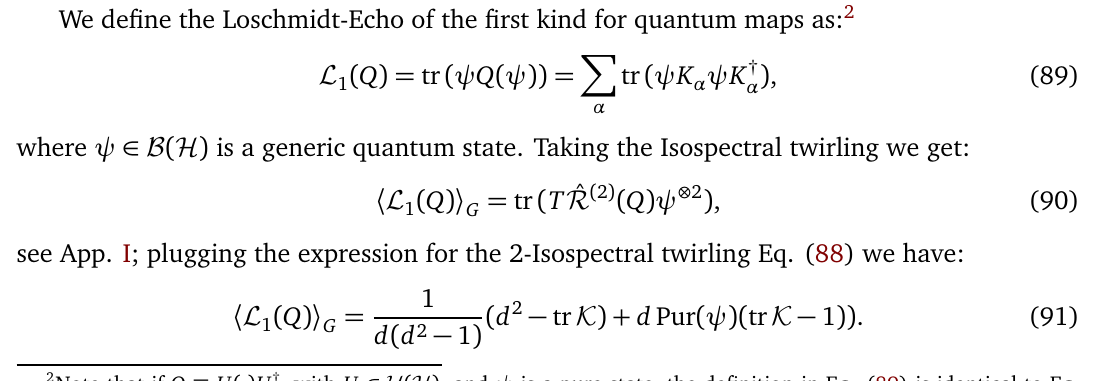
Figure 11: Upper and lower bounds for normalized extractable work 〈 ∆ F 〉 Poisson, GUE and GDE ensemble for d = 2 16 , d There is a trade off for ε = log d positive, see Eq.